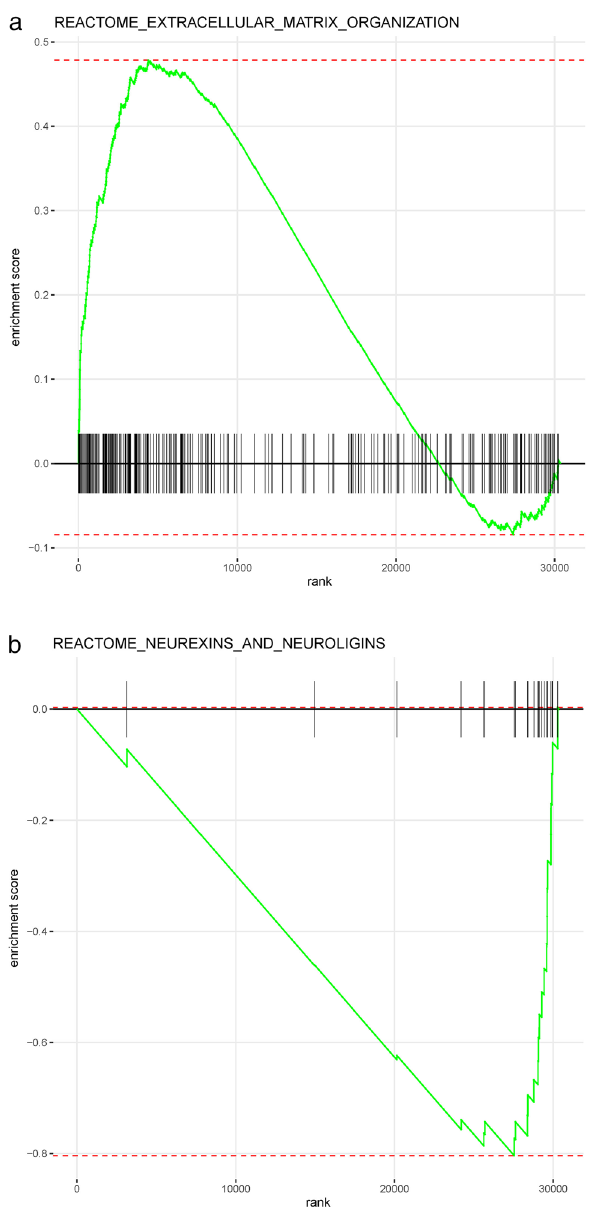
Figure 2. Changes in ES value (y axis) as GSEA was run down the ordered gene list (x axis). The score at the highest or lowest peak of the plot is the ES score for the gene set. ( a ) ES = 0.479 (Table 1) for the Reactome pathway Extracellular matrix organization (R-HAS-1474244); ( b ) ES = − 0.804 for Neurexins and neuroligins